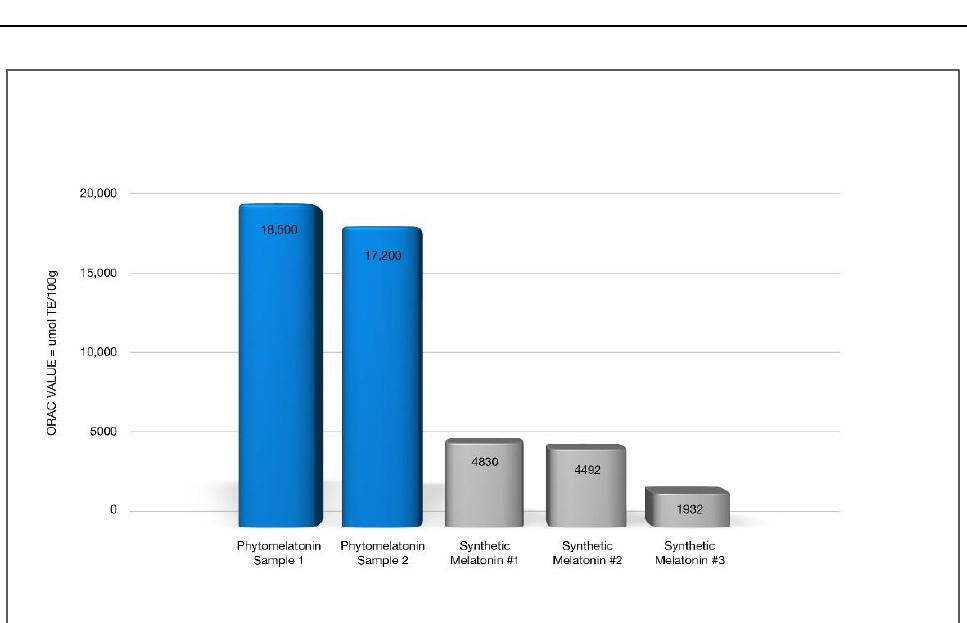
Figure 8. Oxygen radical absorbance capacity (ORAC) of two samples of phytomelatonin (blue bars) and three types of synthetic melatonin (gray bars) [272,273]. and three types of synthetic melatonin (gray bars)